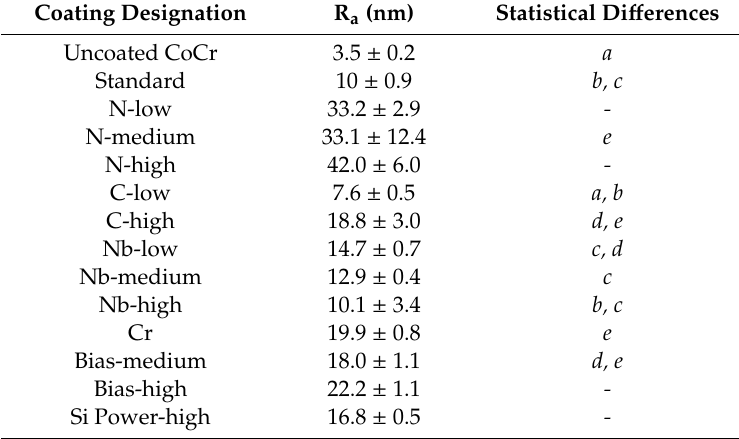
Table 3. Average surface roughness of SiNx coatings, as measured by interferometry. Coatings attributed with the same letters from a–e were not statistically significantly di ff erent (i.e., p > 0.05).